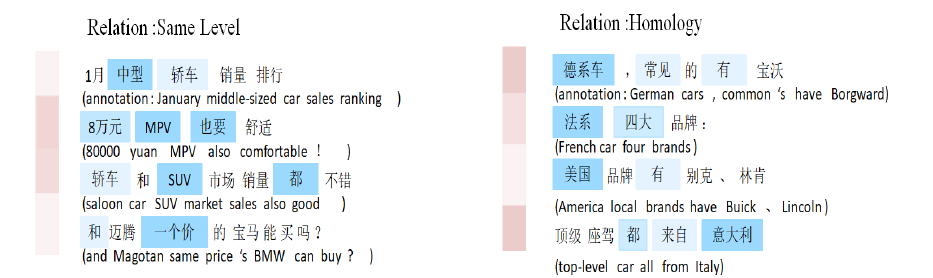
Figure 8. Example of visualization of attention.